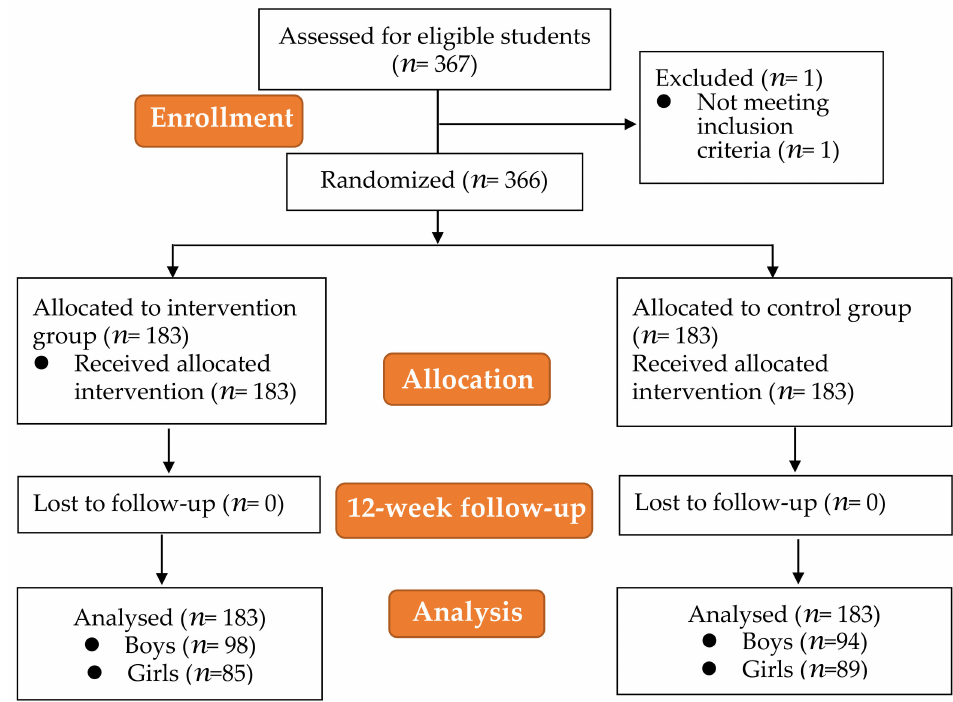
Figure 2. Flow diagram of the study participant selection.